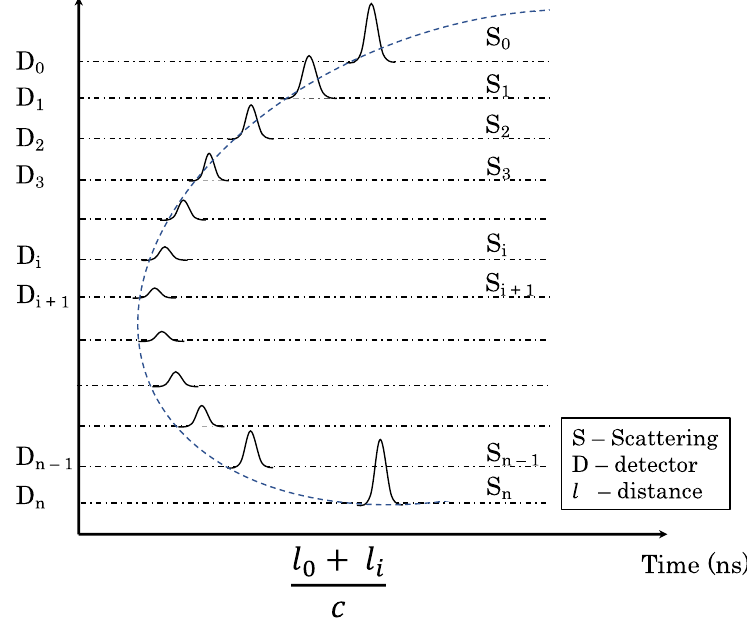
Figure 3. Principle of the proposed time gate to identify the pollutant particles from the correct scattering center. Due to the pulsed emission of the incident laser source, scattering from different scattering centers will arrive at the detector at different time intervals 𝑡 𝑖 = 𝑙 0 +𝑙 𝑖 known distance from the laser to the scattering particle source and l i is the distance from the scattering particle to the i th detector.